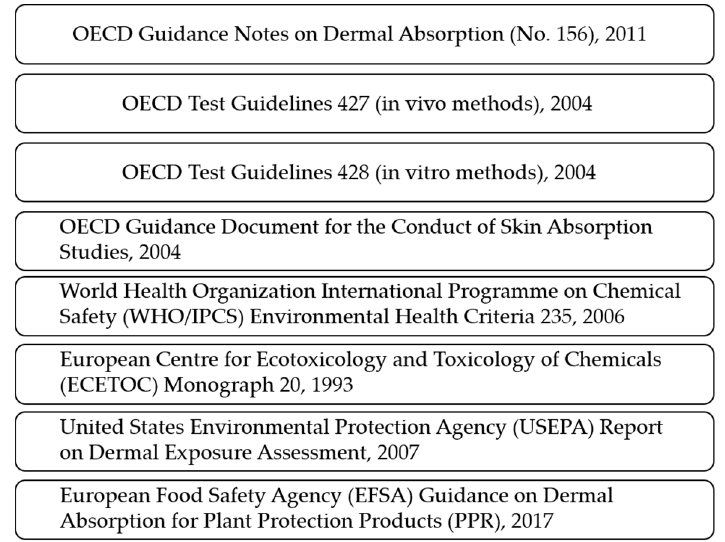
Figure 4. Guidelines for modelling dermal penetration/permeation.